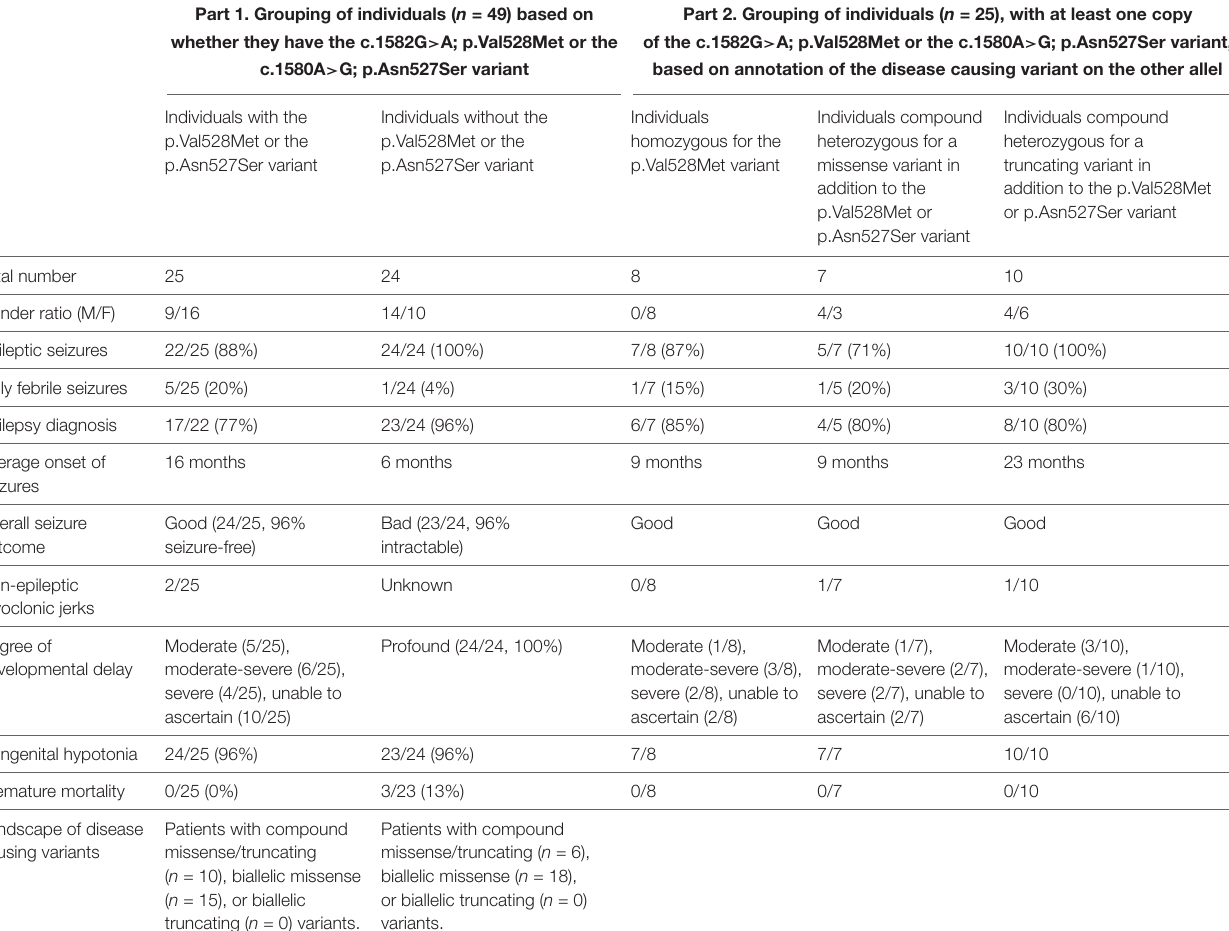
TABLE 2 | Brief clinical overview of all published individuals with PIGT